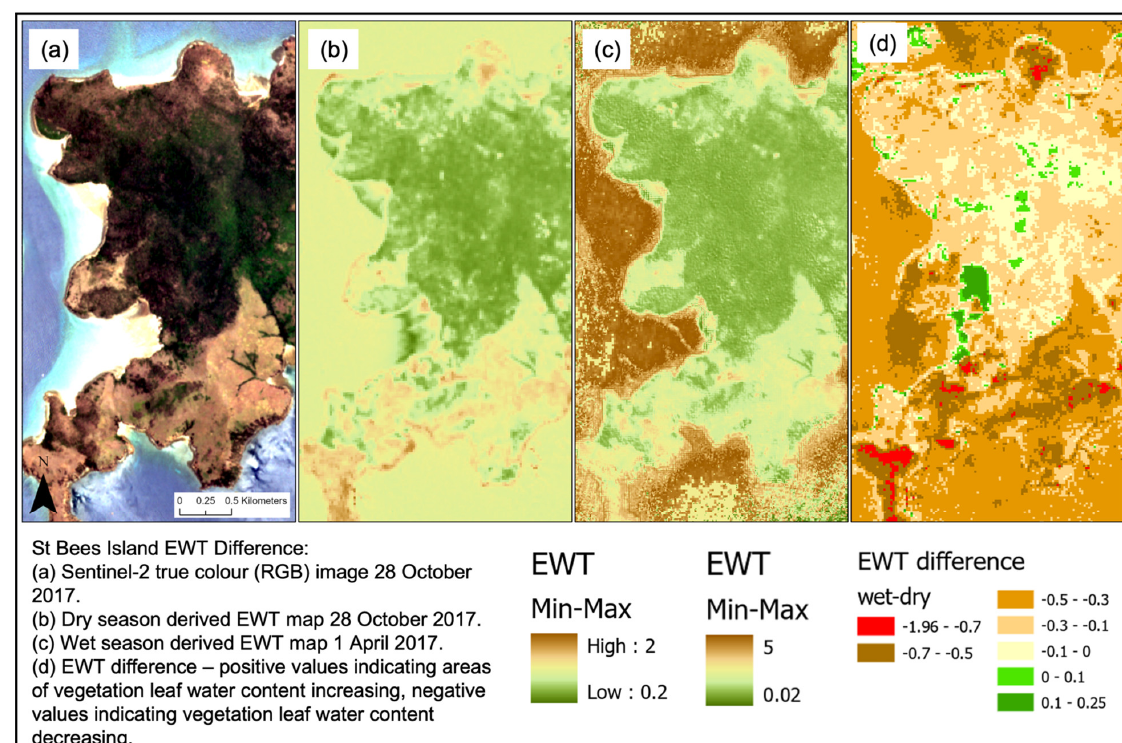
Figure A11. St Bees Island LAI Difference.